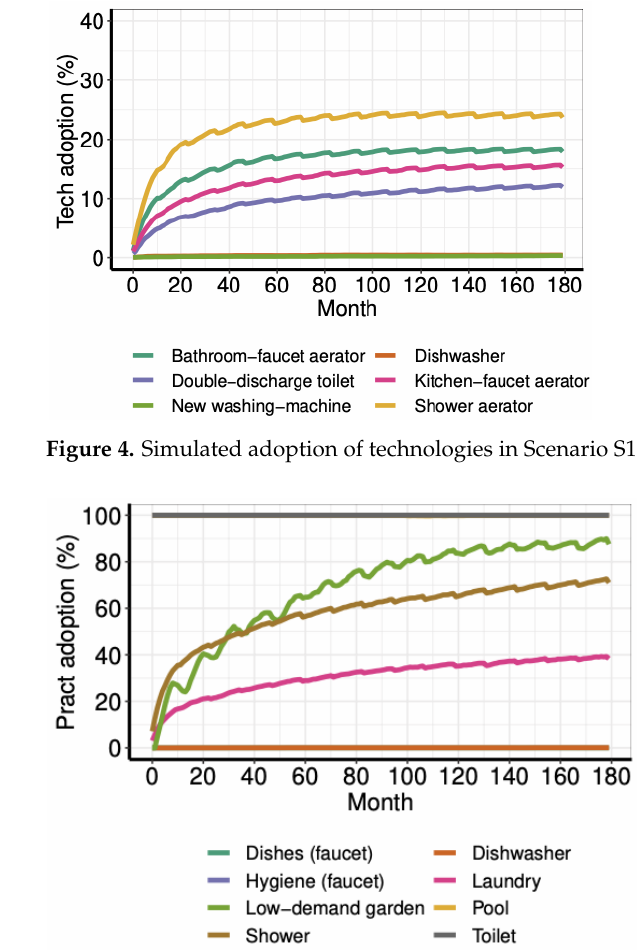
Figure 5. Simulated adoption of practices in Scenario S1.